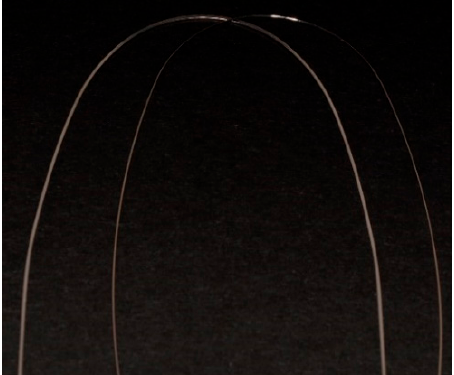
Figure 2. Orthodontic archwires used in the study (AlphaWire, Orthofocus, Bucharest, Romania). For conventional brackets the archwire was fixed by means of transparent elastomeric ligatures (0.12” diameter Opal Orthodontics, Ultradent, South Jordan, UT, USA), applied to the models before each test round (Figure 3).